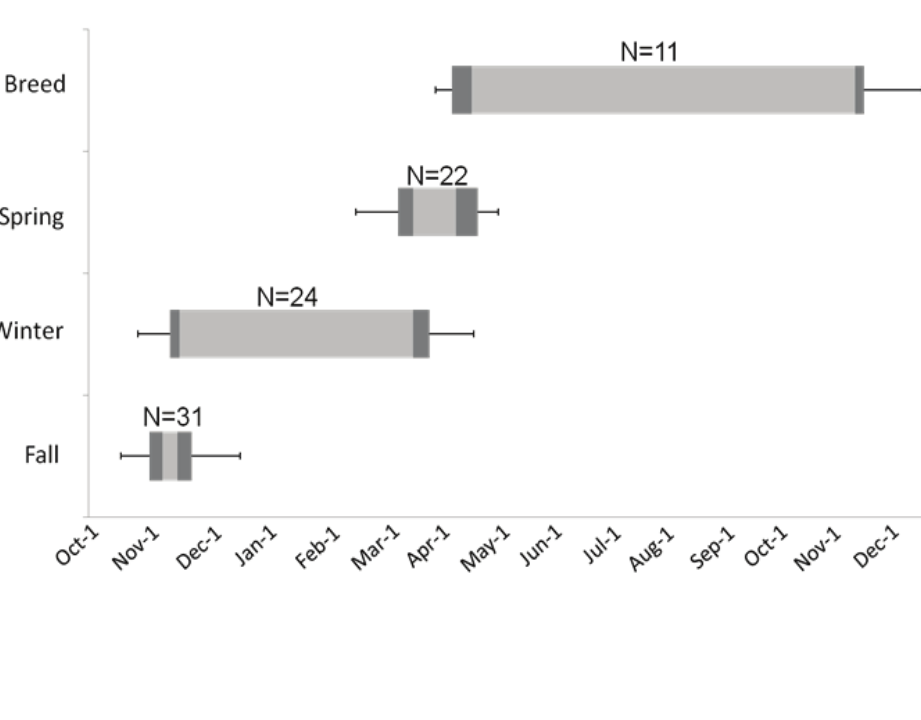
Figure 2. Seasonal movements (fall migration, winter, spring migration, and breeding/post-breeding) over three years for ruddy shelducks marked at Qinghai Lake, China. Seasonal movements were calculated for 20 shelducks with at least one full fall migration; birds with multiple annual cycles were treated as unique individuals in subsequent years. Light gray bars give median period start dates to median end dates, dark gray depicts the innermost 75th percentile, and error bars indicate first and last recorded dates within a